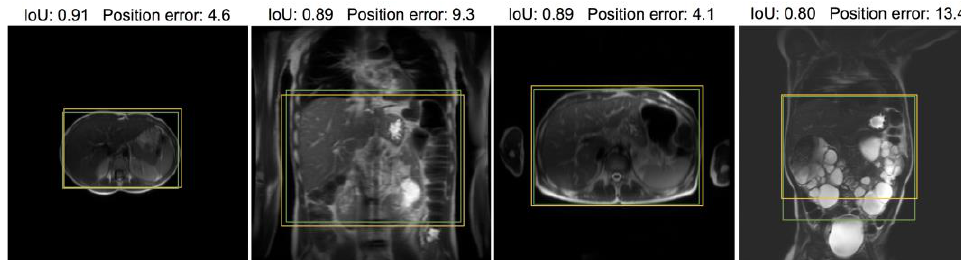
Figure 7. Samples from abdominal localizer test dataset annotated with intra-stack attention model- predicted ROI (yellow) and the ROI label given by radiologists (green). For visual interpretation of the quantitative results, the position error and IoU for the model prediction in each example are included. Note that only one representative slice of a stack is shown, and neither ROI was determined merely from this slice. The left three samples are representative of the average model performance, while the rightmost example is a poorly performed case. Note that the rightmost one is an extreme case of polycystic kidney disease.